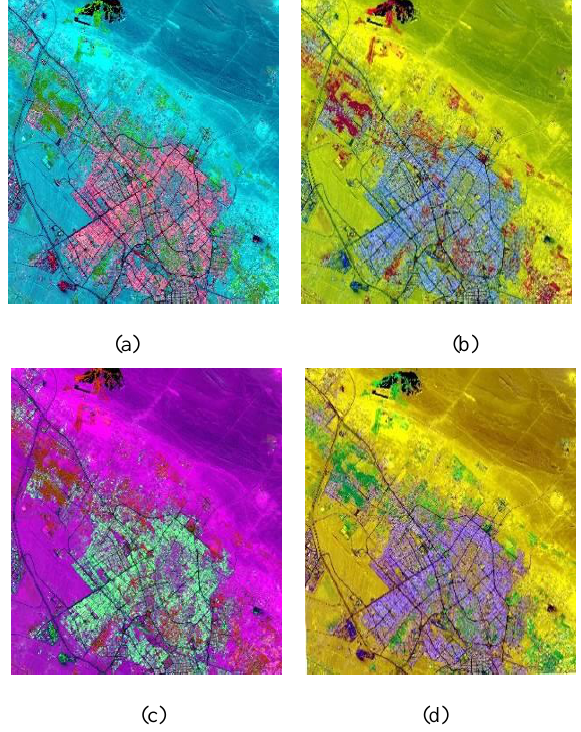
Figure 2. Band Combination technique for Sentinel 1, 2 images: (a) Band C, 8, 4 (b) Band 8, 4, C (c) Band 8, C, 4 (d) Band 4, 8, C.